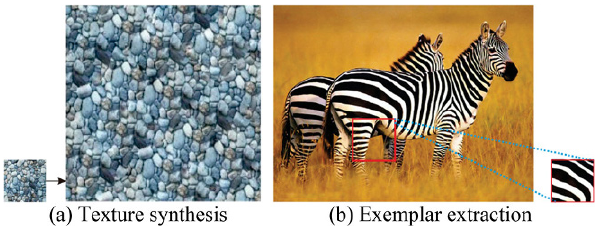
Fig. 1 Texture synthesis and exemplar